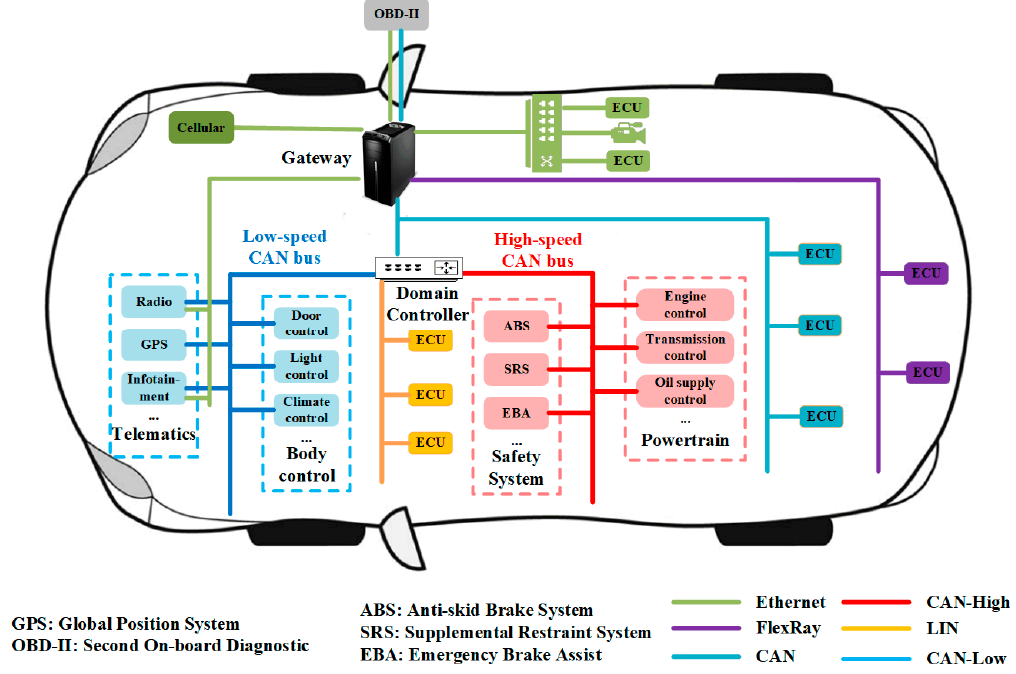
Figure 1. Architecture of the IVNs.